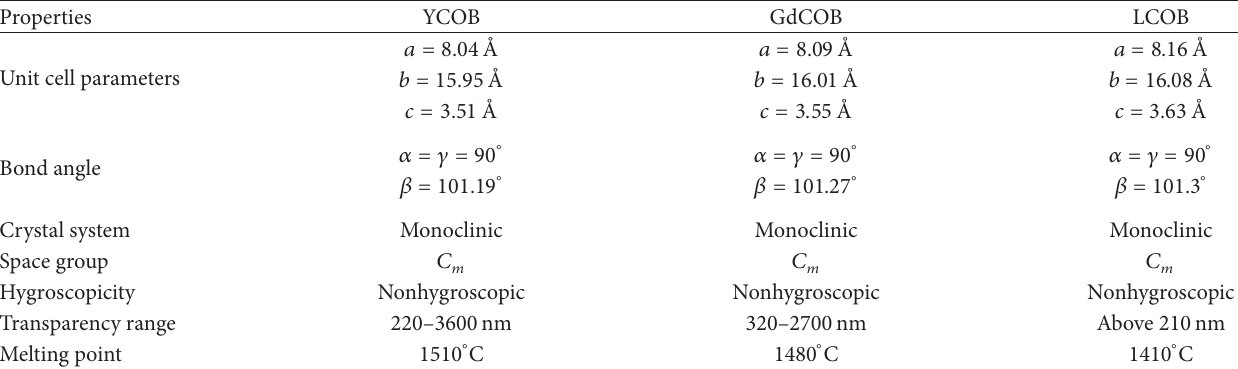
T 2: Comparison between RECOB